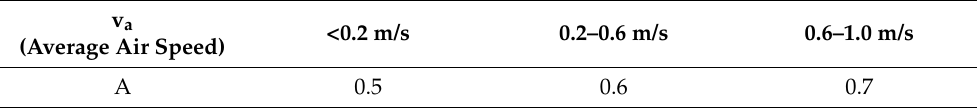
Table 8. A value for calculating operative temperature at more than 0.2 m/s air velocity.